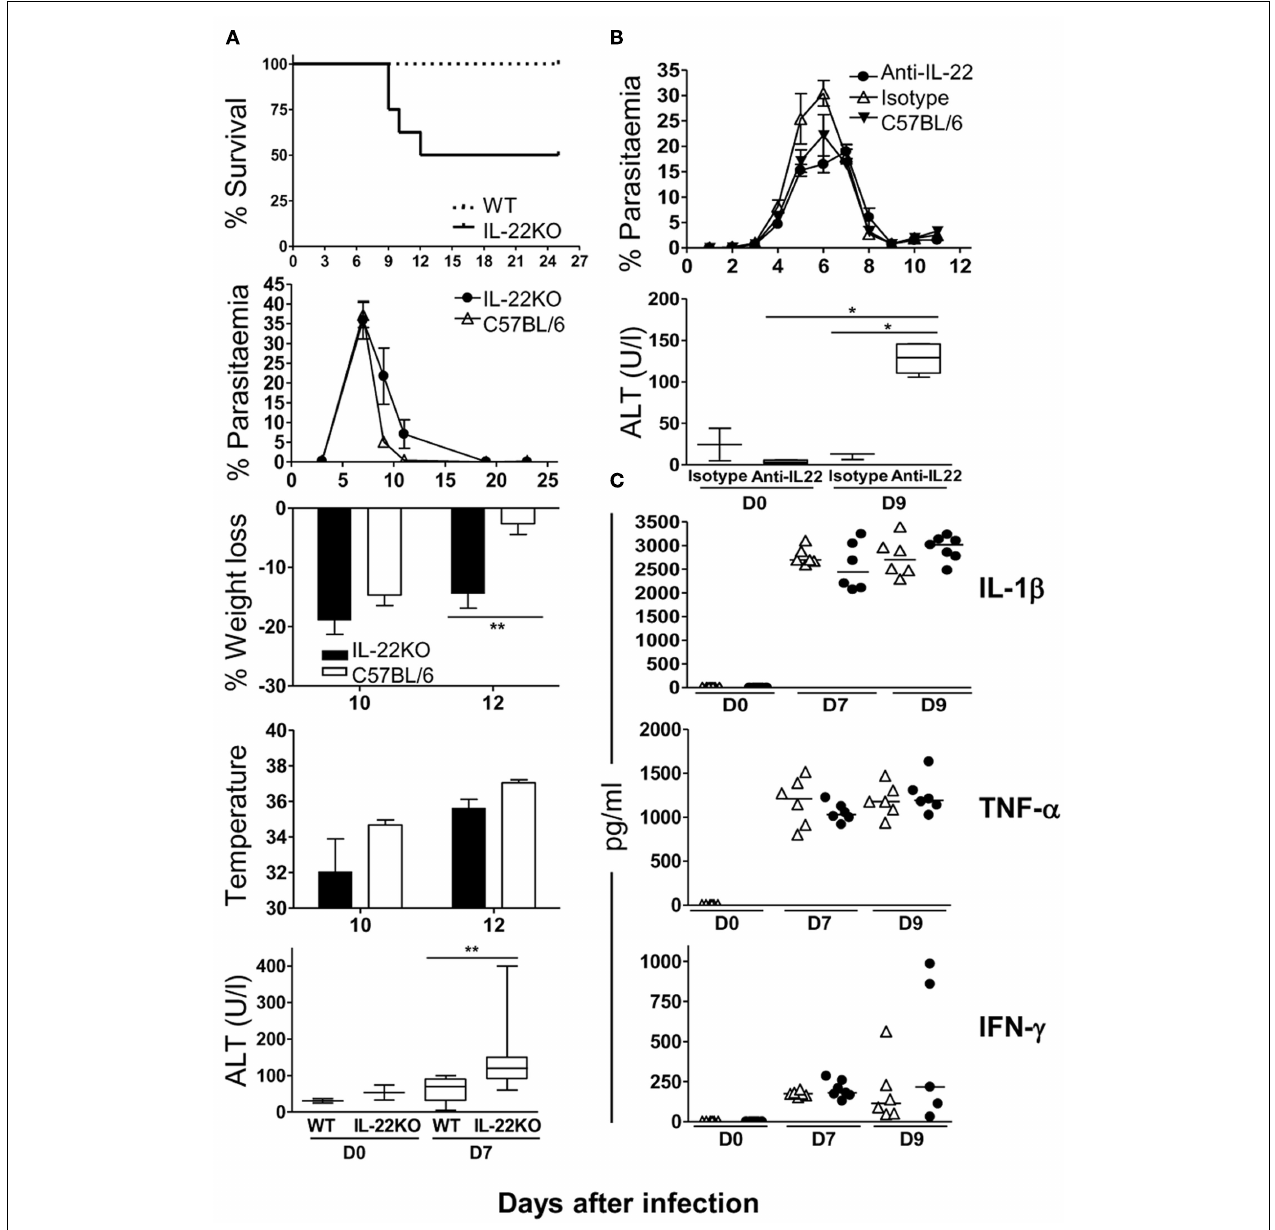
Cobas C111 chemistry analyzer. Data are means and SEM of five mice and representative of two experiments. Significant differences are shown using a Mann–Whitney U -test of five mice [*significant P -value (0.01–0.05), **very significant P -value (0.001–0.01)]. (A) Survival, parasitemia, pathology, and liver damage in IL-22 KO andWT mice. (B) Parasitemia and ALT levels in anti-IL-22 treated or control mice. (C) Plasma IL-1 β ,TNF- α , and IFN- γ levels were determined by ELISA in naïve and day 7 and 9 infected IL-22 KO mice andWT mice.The numbers and the median are represented of four